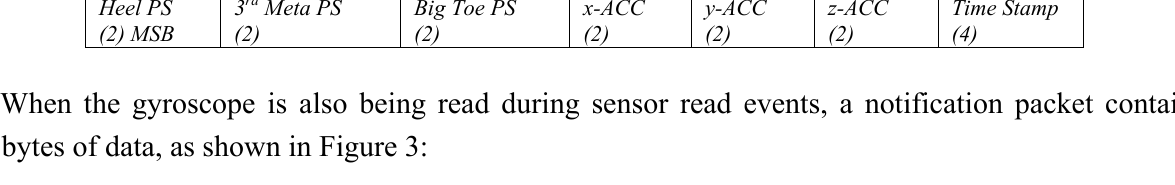
Figure 3. Notification packet when the gyroscope is